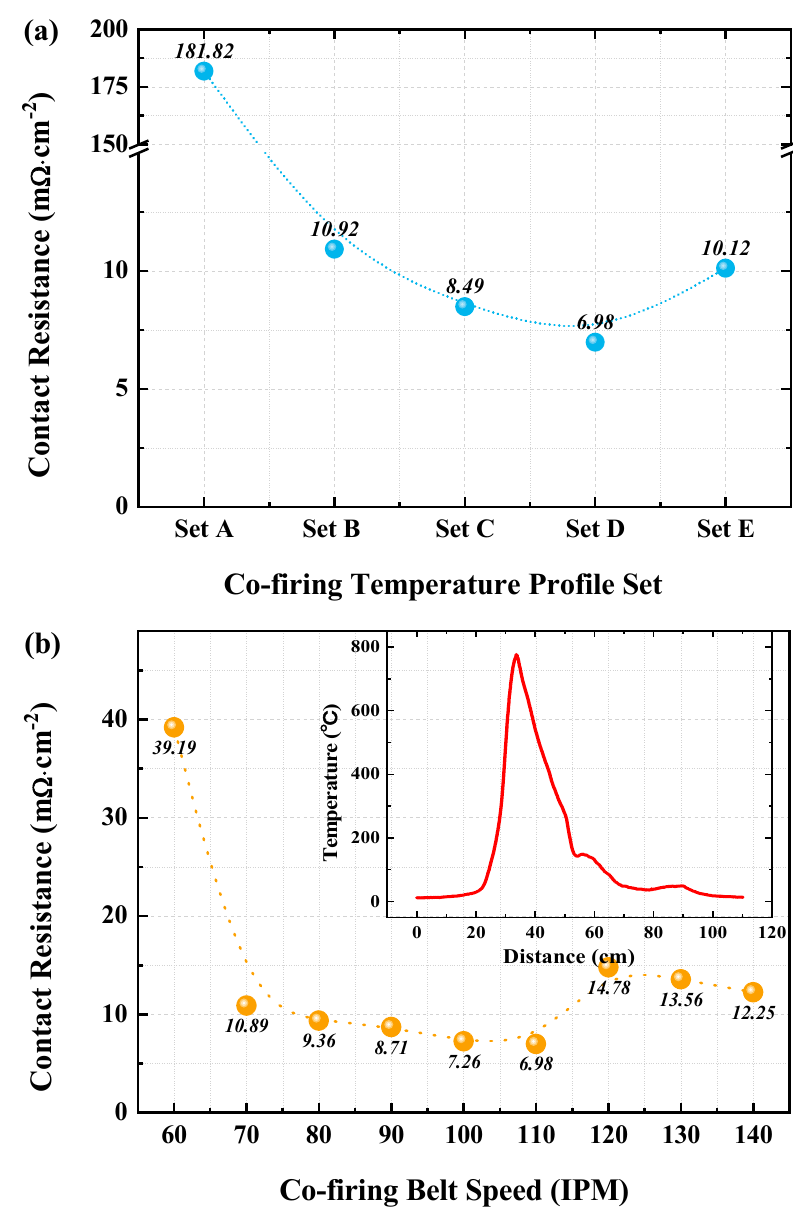
Figure 2. Analysis of R C of front electrodes formed by the screen-printing process using Ag–Al paste with variation in the co-firing process condition: ( a ) peak temperature and ( b ) belt speed.